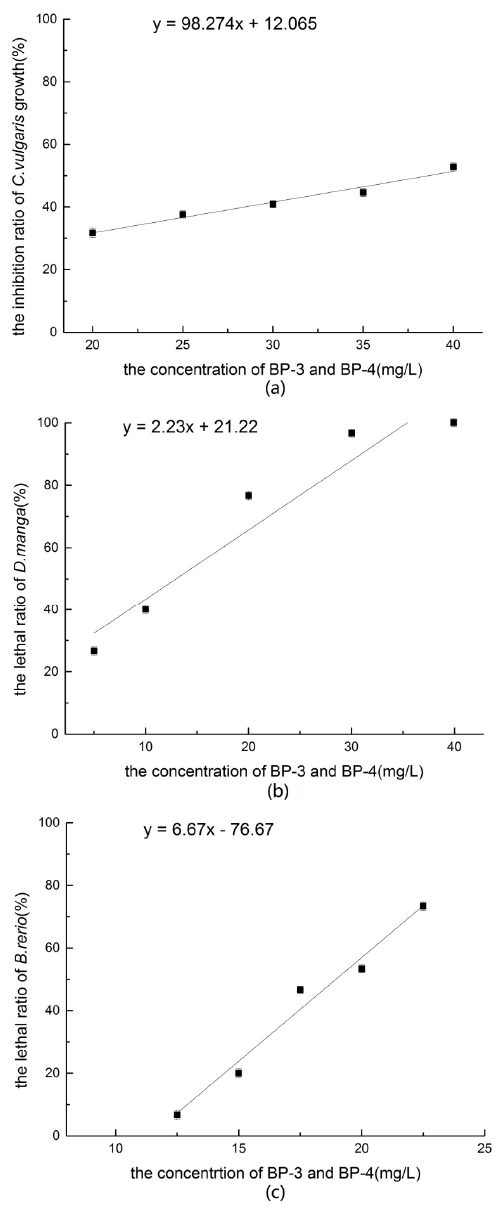
Figure 3. ( a ) The inhibition ratio of C. vulgaris growth of BP-3 and BP-4; ( b ) The lethal ratio of D. magna of BP-3 and BP-4; ( c ) The lethal ratio of B. rerio of BP ‐ 3 and BP ‐ 4.